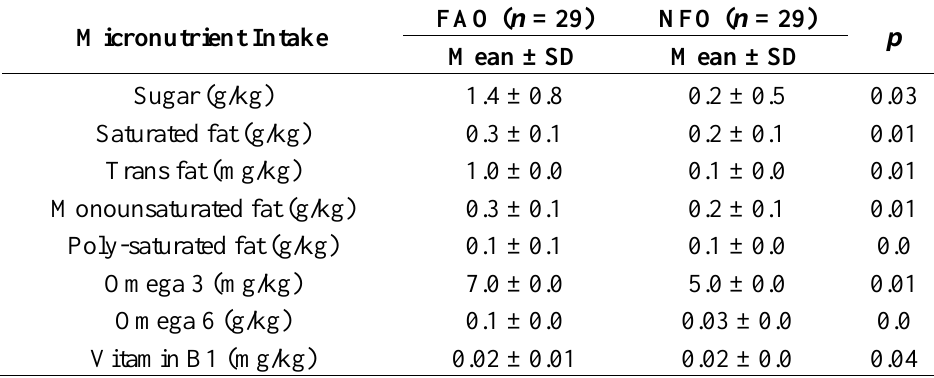
Table 4. Significant differences of selected micronutrient intakes between food addicts (FAO) and non-food addicts (NFA) of overweight/obese groups